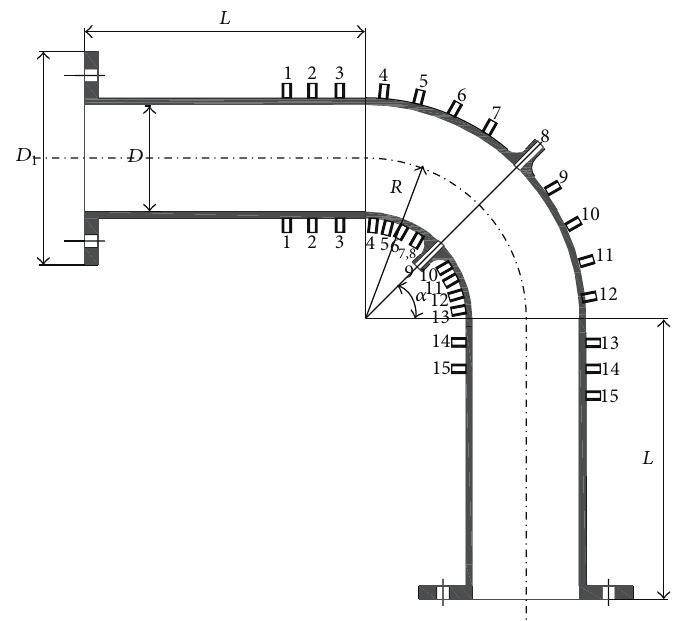
Figure 2: Arrangement of measuring orifices of 90 ∘ elbow.